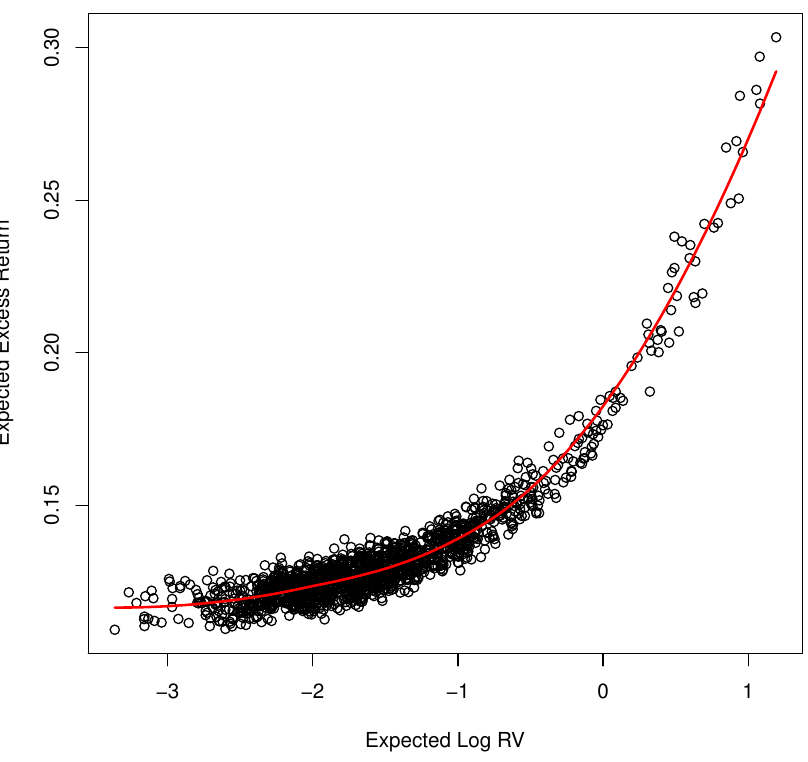
Figure 9. Expected excess return when volatility feedback is